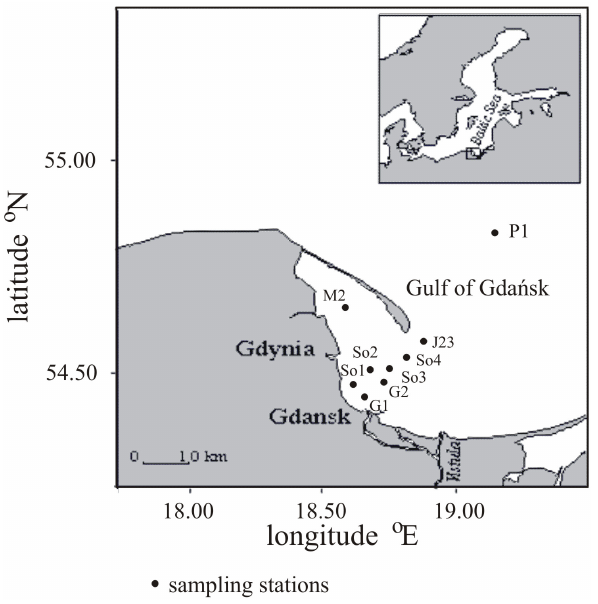
Fig. 1. Location of the sampling stations; full circles – sampling